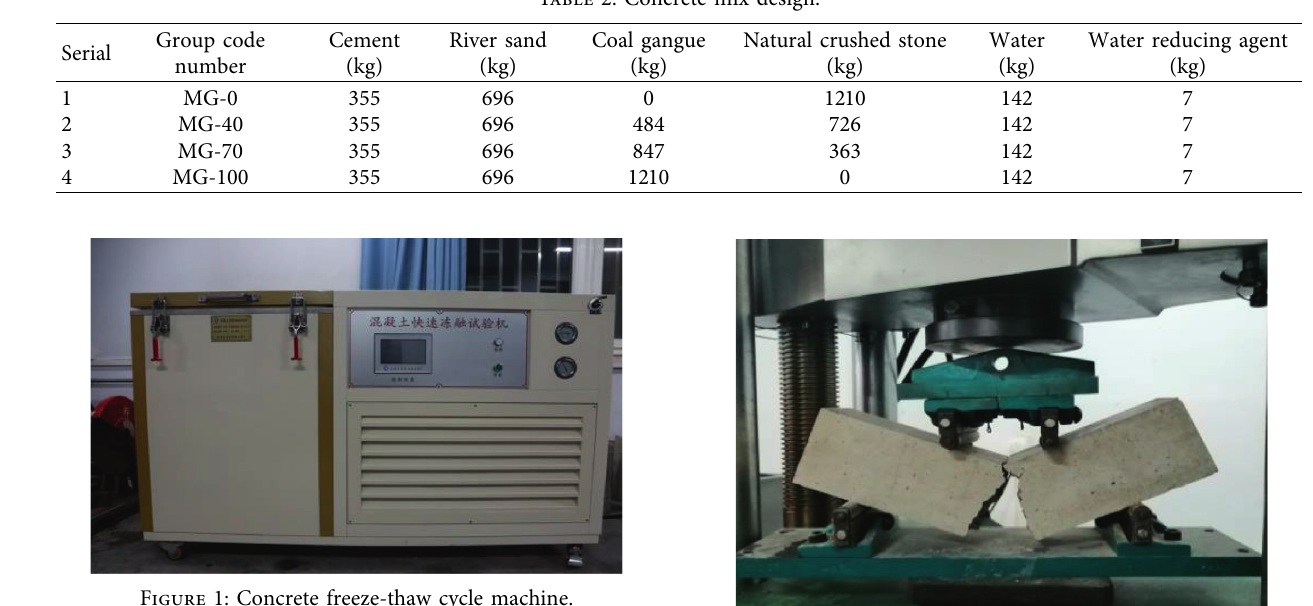
Table 2: Concrete mix design.